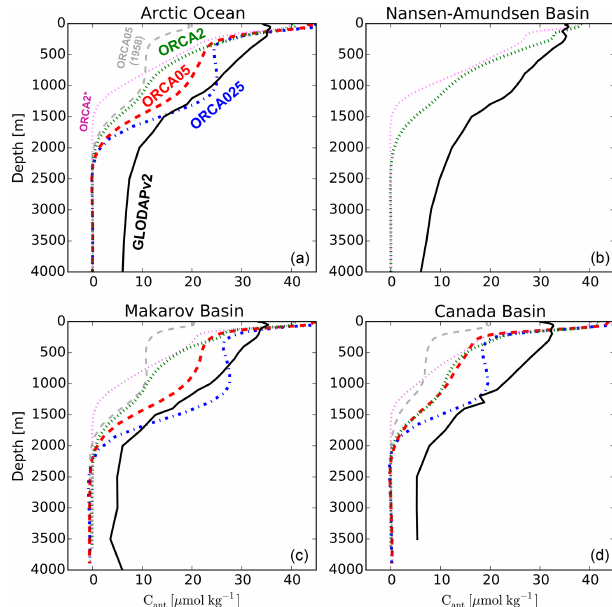
Figure 7. Area-weighted basin-wide average vertical profiles of C ant concentration in 2002 for GLODAPv2 data-based estimates (black solid), ORCA2 (green dots), ORCA05 (red dashes), and ORCA025 (blue dot–dash) over the entire Arctic (a) as well as over the Nansen and Amundsen basins (b) , the Makarov Basin (c) , and the Canada Basin (d) . Ocean corrected for the starting year by the perturbation approach simulations. Shown are the vertical profile in 1958 (dashed, light grey), the branching point for the three resolu- tions, and results from ORCA2 ∗ for 2002 (magenta